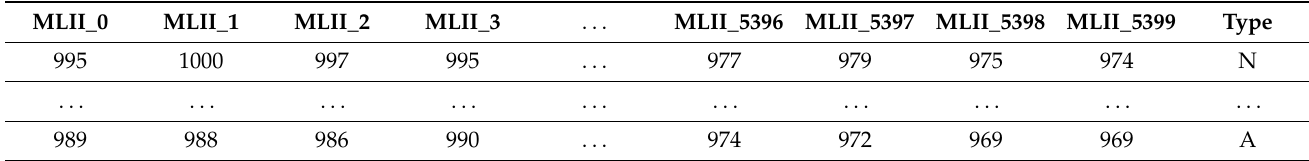
Table 2. Data organization of one 30-min ECG recording fragmented into segments. Columns from MLII_0 to MLII_539 represent samples contained in 15 s fragment. Each row is a different and consecutive fragment. Type N = normal, A =